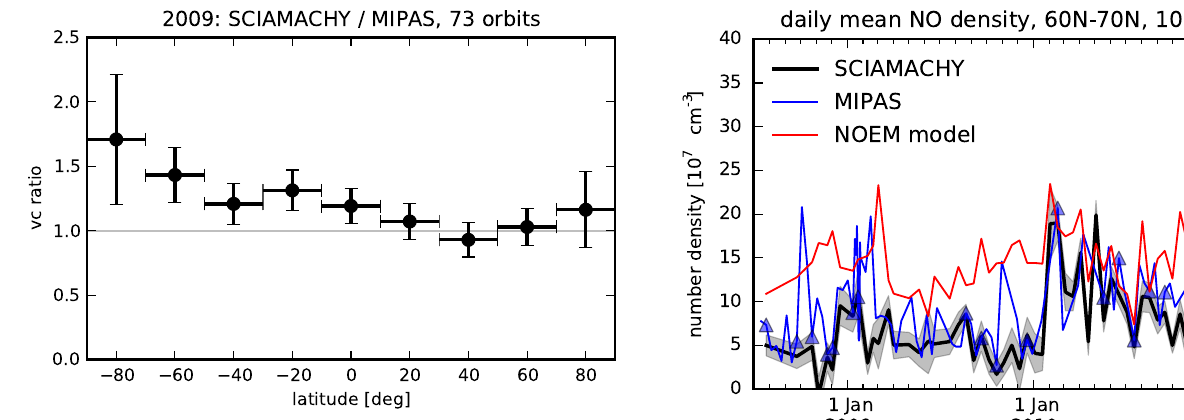
Fig. 14. Auroral daily mean nitric oxide number density at 106km, SCIAMACHY MLT (black) and MIPAS UA (blue) compared to the NOEM model (red) (Marsh et al., 2004) based on SNOE data (Barth et al., 2003). The grey shaded area shows the 3 σ confidence interval of the SCIAMACHY daily means and the blue triangles indicate coincident SCIAMACHY MLT and MIPAS UA measurement